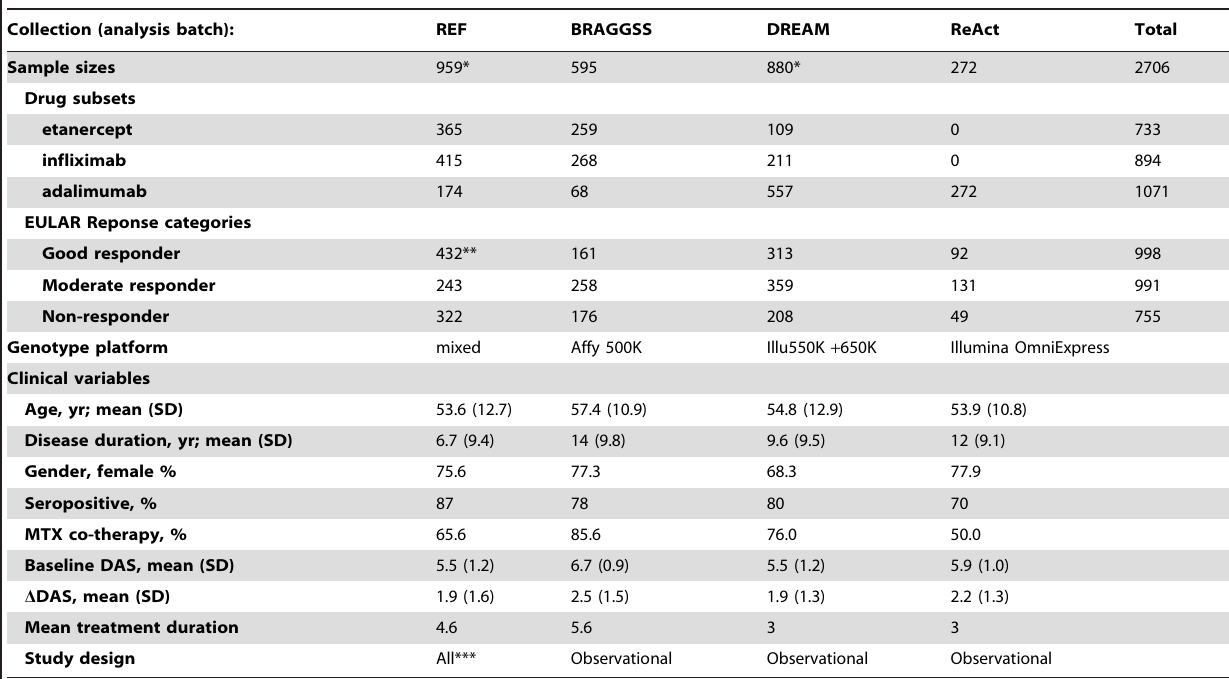
Table 1. Samples and clinical